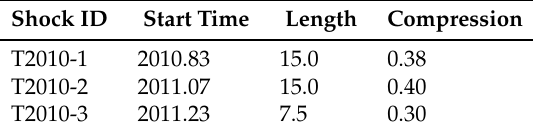
Table A4. Shock attributes for